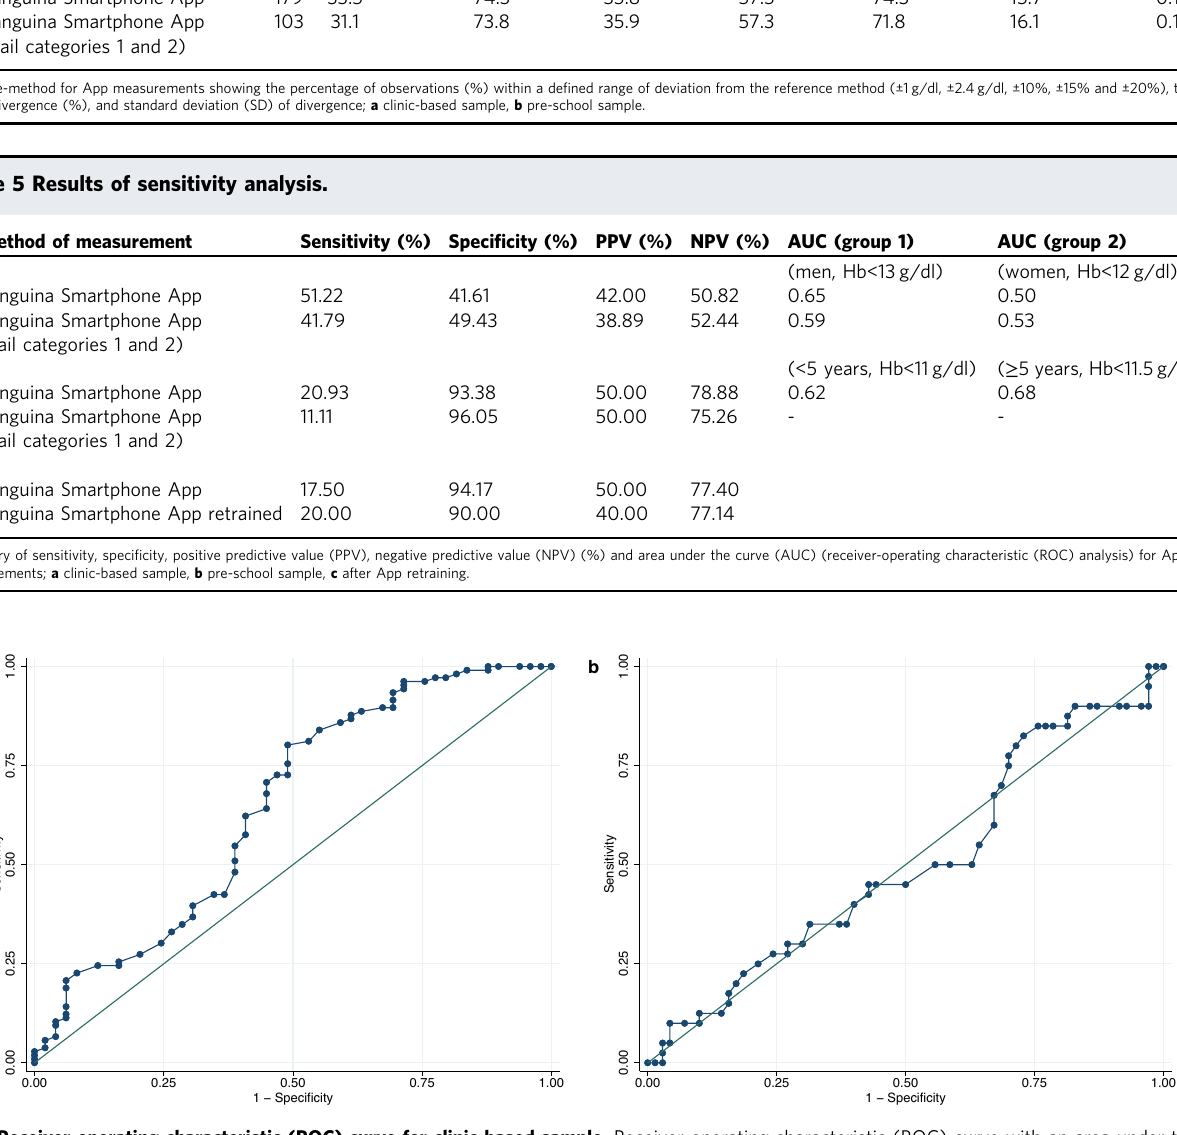
Fig. 4 Receiver-operating characteristic (ROC) curve for clinic-based sample. Receiver-operating characteristic (ROC) curve with an area under the curve (AUC) of a 0.65 for men ( ≥ 15 years of age, n = 155) and b 0.50 for women ( ≥ 15 years of age, n = 110) in the clinic-based sample. Source data is in Supplementary Data categories 1 and 2 revealed an AUC of 0.59 for men and 0.53 for women (Supplementary Fig. 6). Within the pre-school sample, Hb values of nail categories 1 and 2 were measured within ±3.00 g/dl and the bias was 1.54 g/dl (Table 3, panel b and Sup- plementary Fig. 5, panel b).